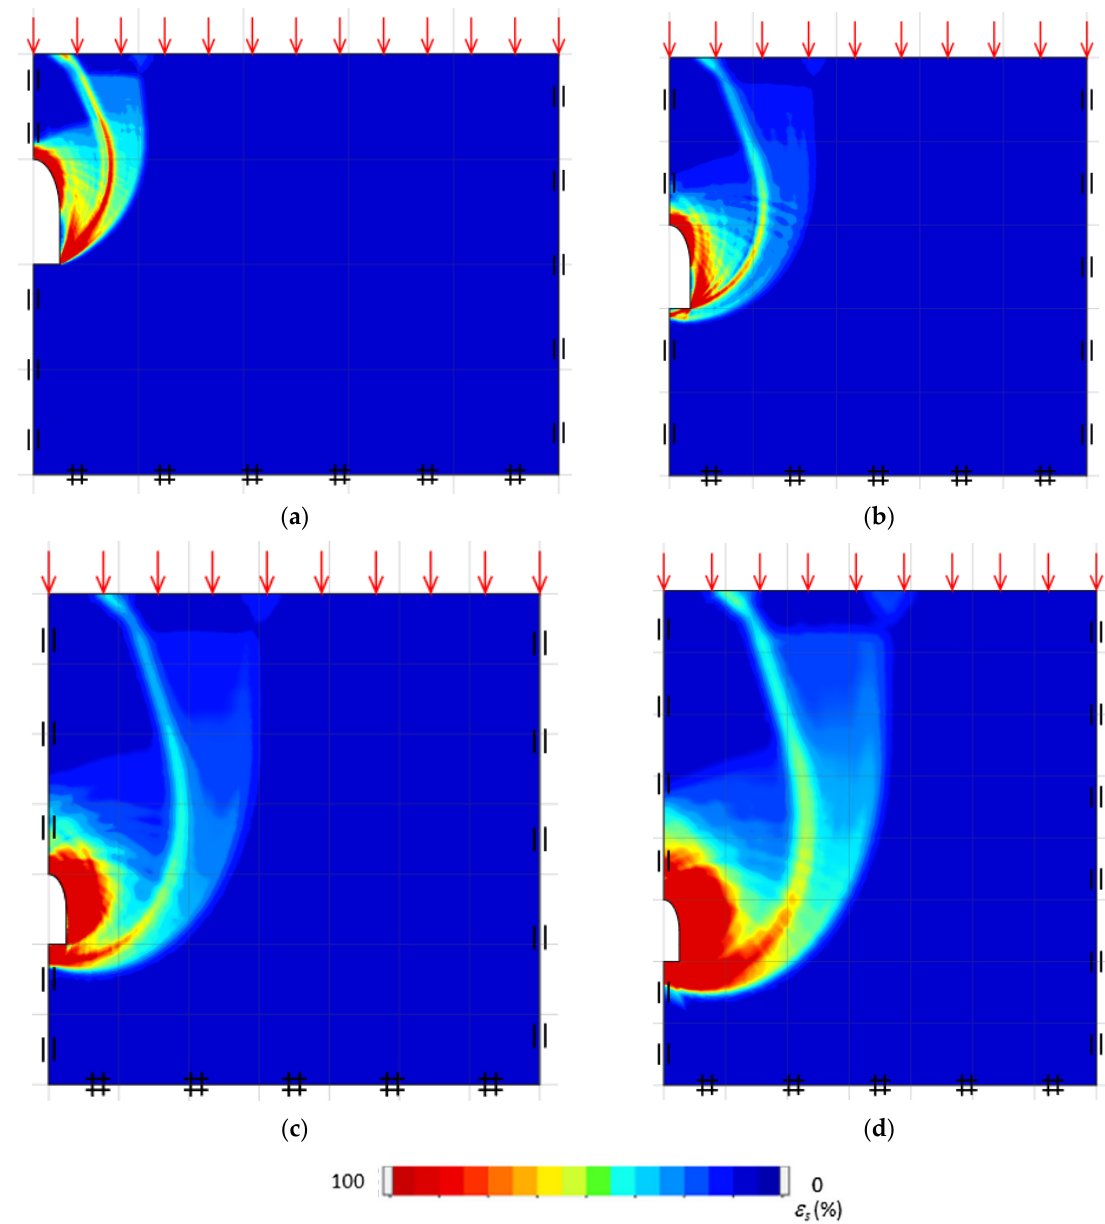
Figure 13. Shear dissipations of horseshoe tunnel with B / D = 0.5 for the cases of C / D : ( a ) 1, ( b ) 2, ( c ) 4 and ( d ) 5 ( σ ci / γ D = 1000, GSI = 80 and m i = 20).